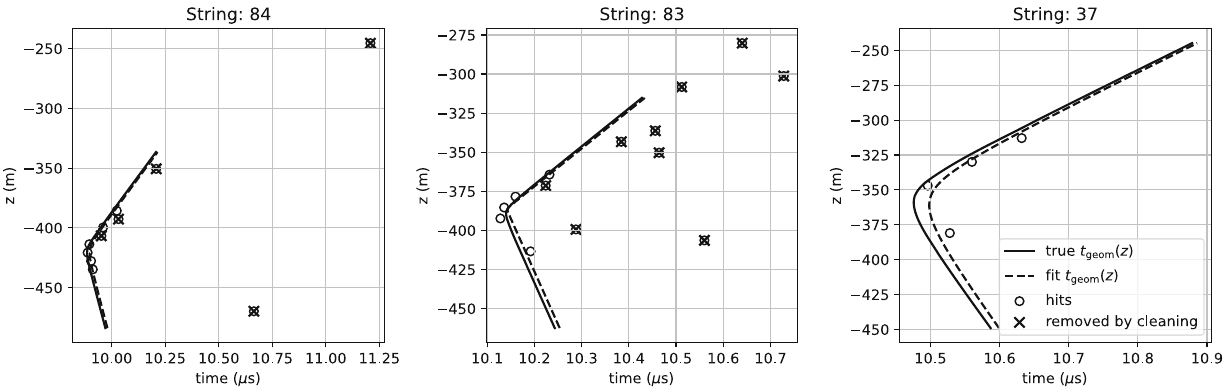
Fig. 4 Example of a ν CC μ event reconstructed with santa with hits on several strings. Strings 84, 83 and 37 are spaced ∼ 80m apart from each other and form a highly obtuse triangle